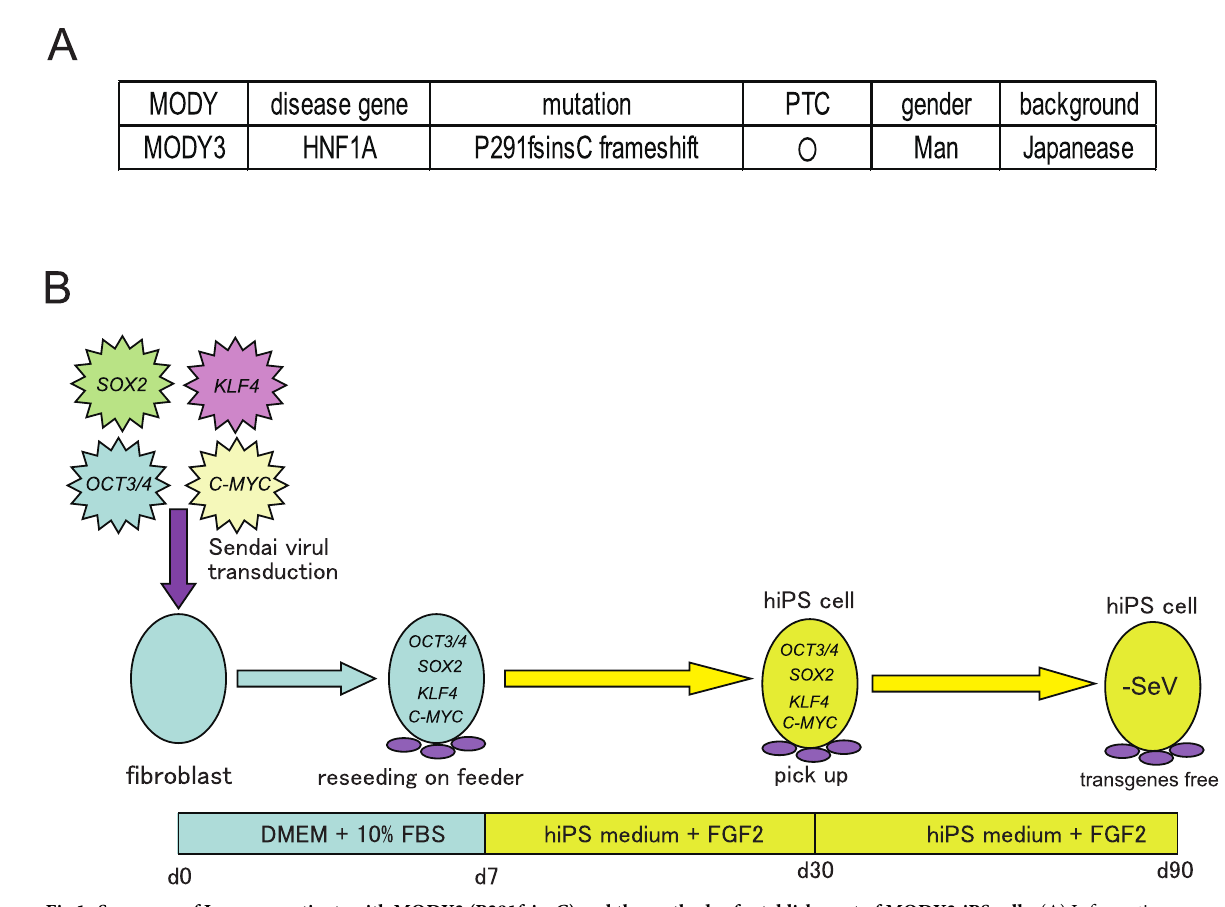
Fig 1. Summary of Japanese patients with MODY3 (P291fsinsC) and the methods of establishment of MODY3-iPS cells. (A) Information about the Japanese MODY3 (P291fsinsC) patient. (B) Time schedule of iPS cell generation using SeV.